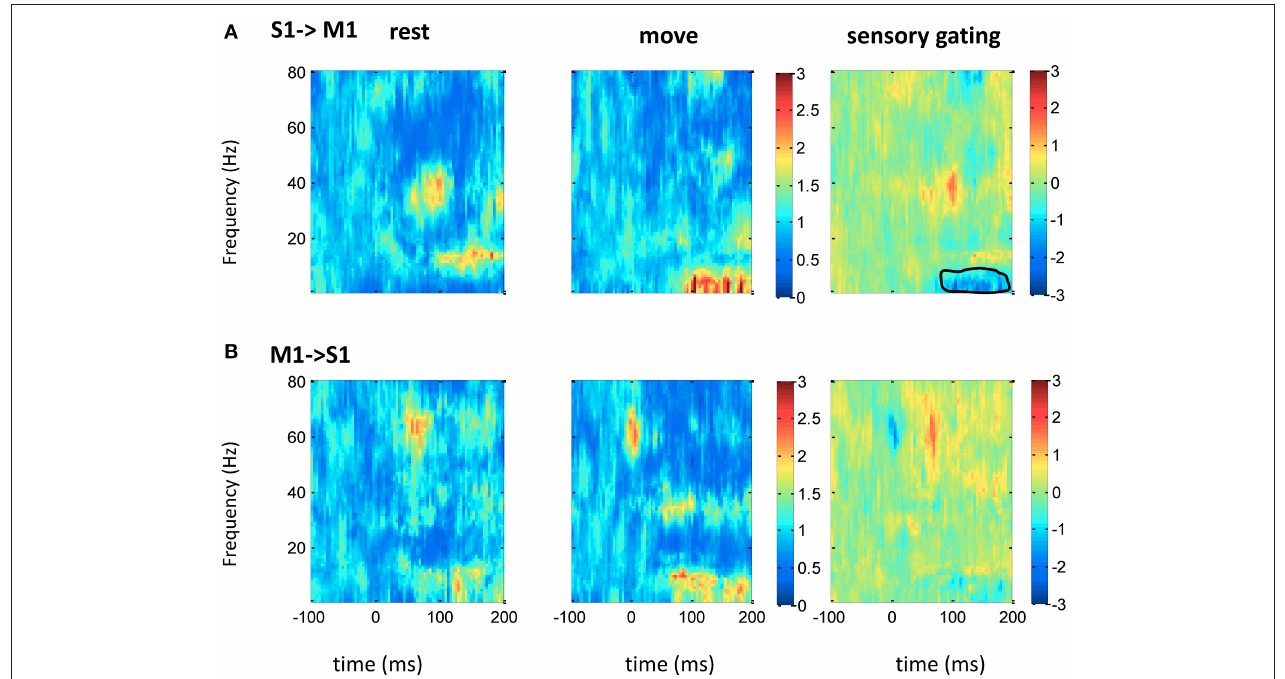
FIGURE 6 | GC between M1 and S1 in frequency domain. After normalizing the GC at each frequency to its baseline (100ms before tactile onset), the time-frequency GC map does not show clear directional coupling pattern from M1 to S1 (A) or from S1 to VPL (B) during rest (left) and movement condition (middle). Instead of sensory gating, movement significantly increases the GC from S1 to M1 at low frequency band (right). Each heatmap is the mean time-frequency representation across sessions ( n = 16 ). The same convention of legend is used as in Figure 5